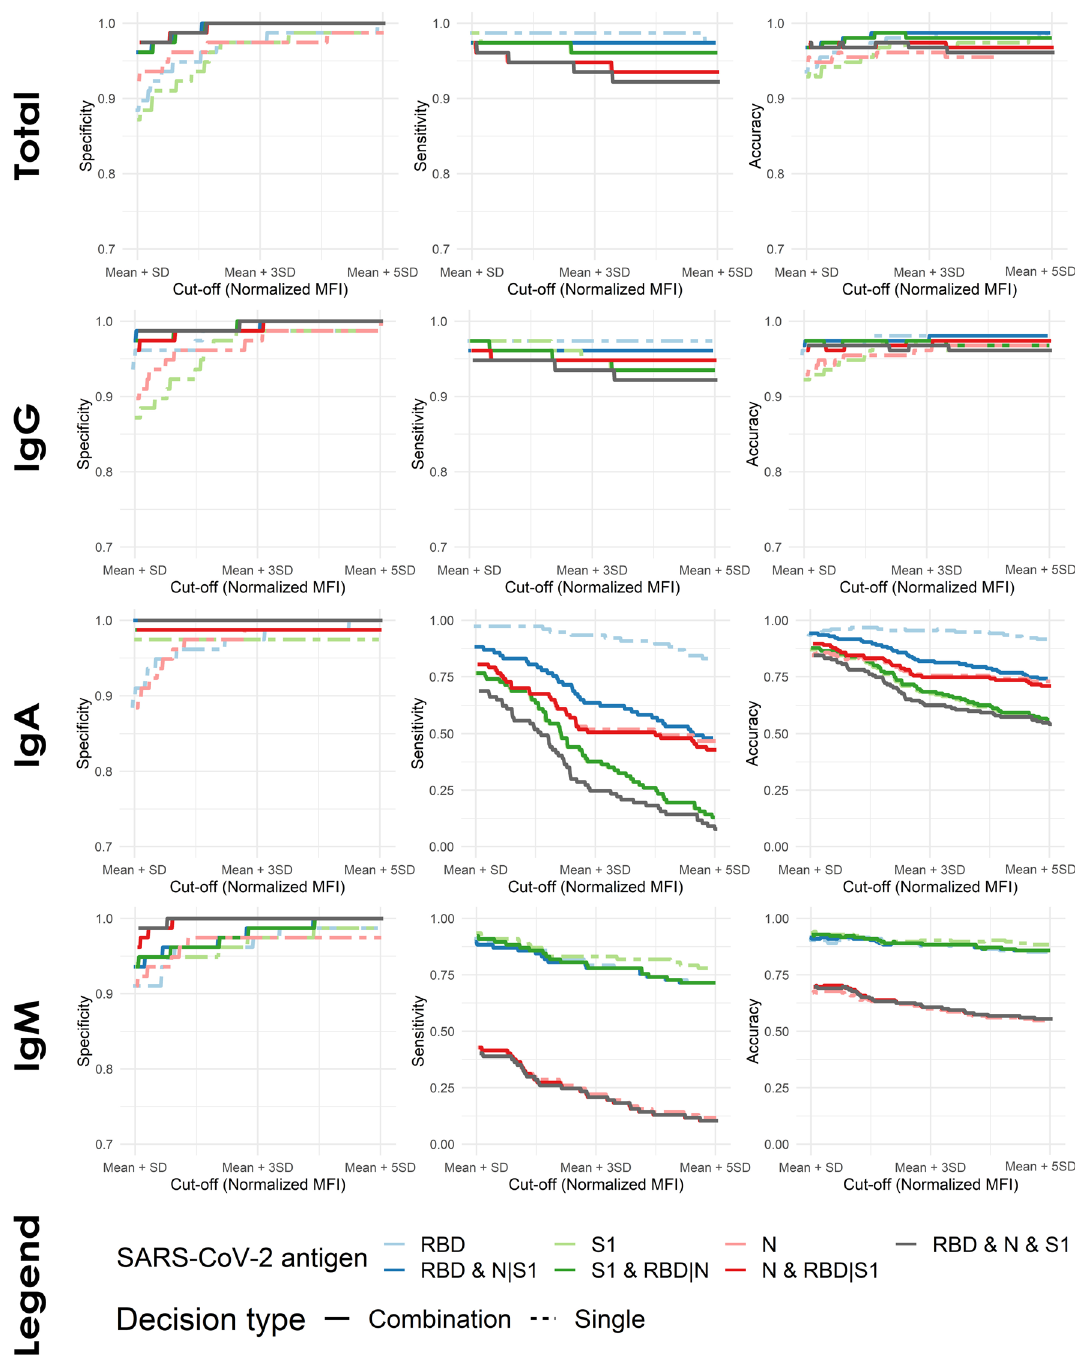
Figure 1. Assay performance metrics for different cut-off thresholds. For each antibody isotype, sensitivity, specificity, and accuracy values were calculated for increasing cut-off thresholds based on the distribution of each antigen’s negative samples. The values on the x axis are normalized MFI, while the different performance metrics are presented as ratios. The single antigen tests are presented with dashed lines, while the multi-antigen rules as solid